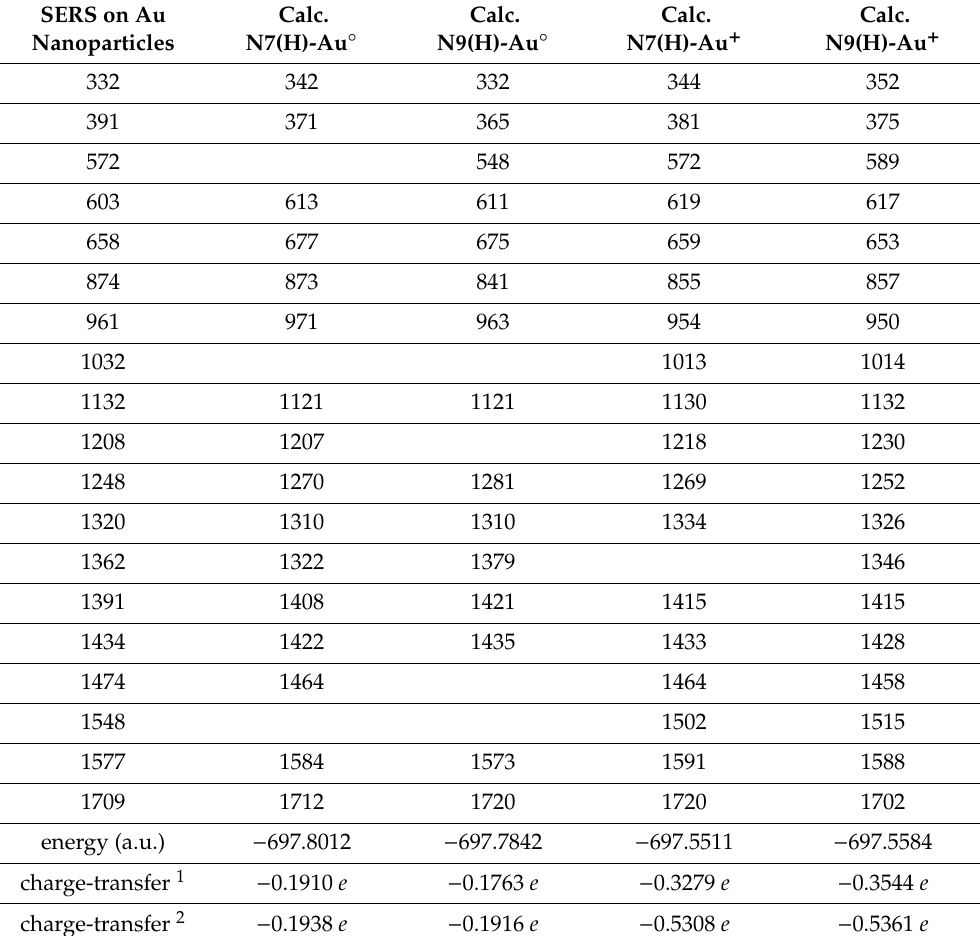
Table 1. Observed and calculated surface-enhanced Raman scattering (SERS) frequencies (cm − 1 ). SERS on